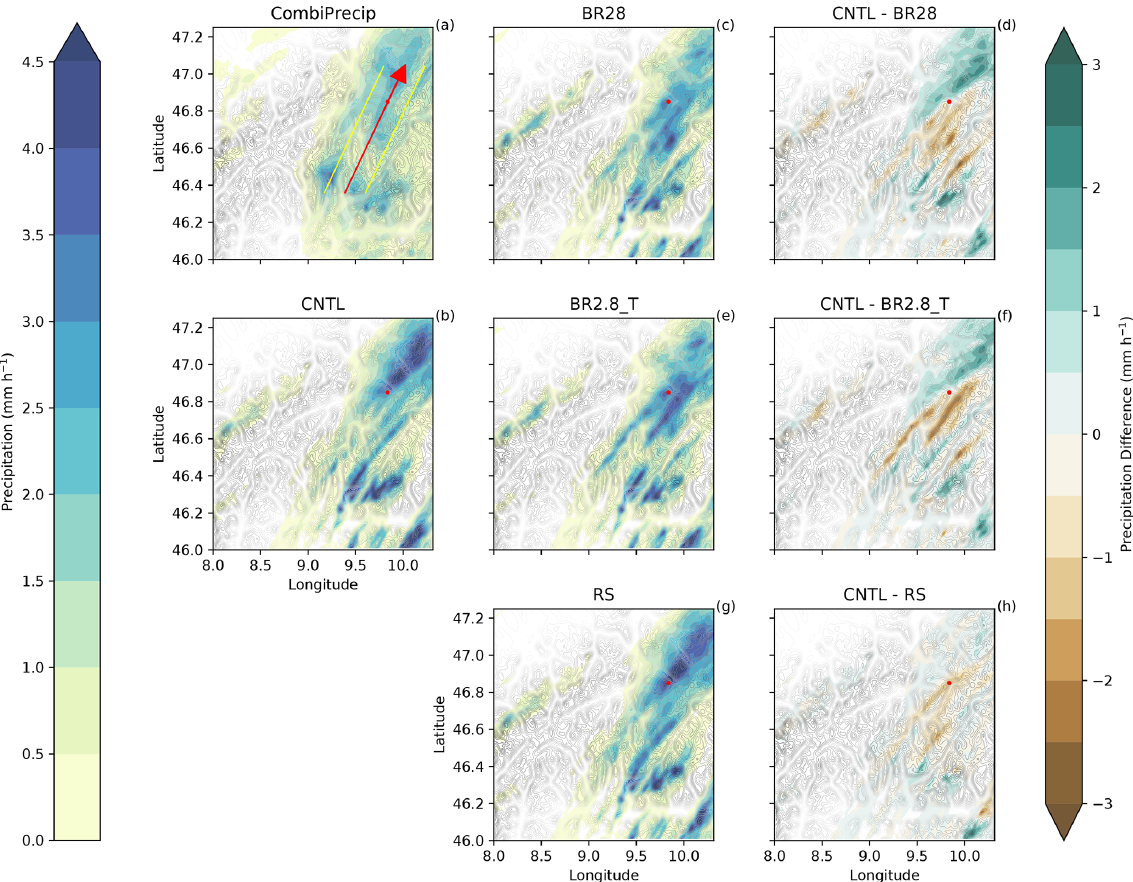
Figure 7. Precipitation rate (millimeters per hour; hereafter mmh − 1 ) over the domain. (a) CombiPrecip, (b) CNTL, (c) BR28, (d) CNTL − BR28, (f) CNTL − BR2.8_T and (h) CNTL − RS. between 12:00 and 14:00UTC. The yellow lines are the outer limits of the cross sections around the red arrow showing the wind direction. The red marker shows the location of Gotschnagrat, and the gray shading is the topography between 0 (white) and 3700m (dark